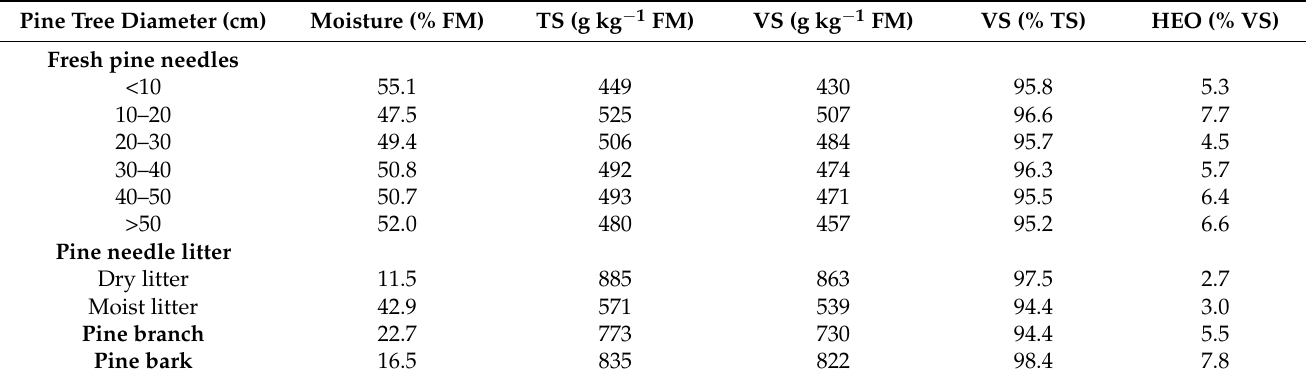
Table 1. Physicochemical properties of fresh pine needles from different diameter trees, pine needle litter, pine branches, and pine